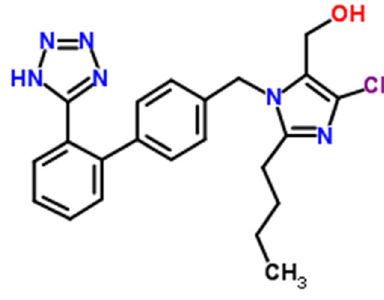
Figure 2. The chemical structure of losartan ((2-Butyl-4-chloro-1-{[2 ′ -(1H-tetrazol-5-yl)-4-bi- phenylyl]methyl}-1H-imidazol-5-yl)methanol , LOS). The structural formula of losartan was drawn with the use of the ACD/ChemSketch ver. 2018.2.1